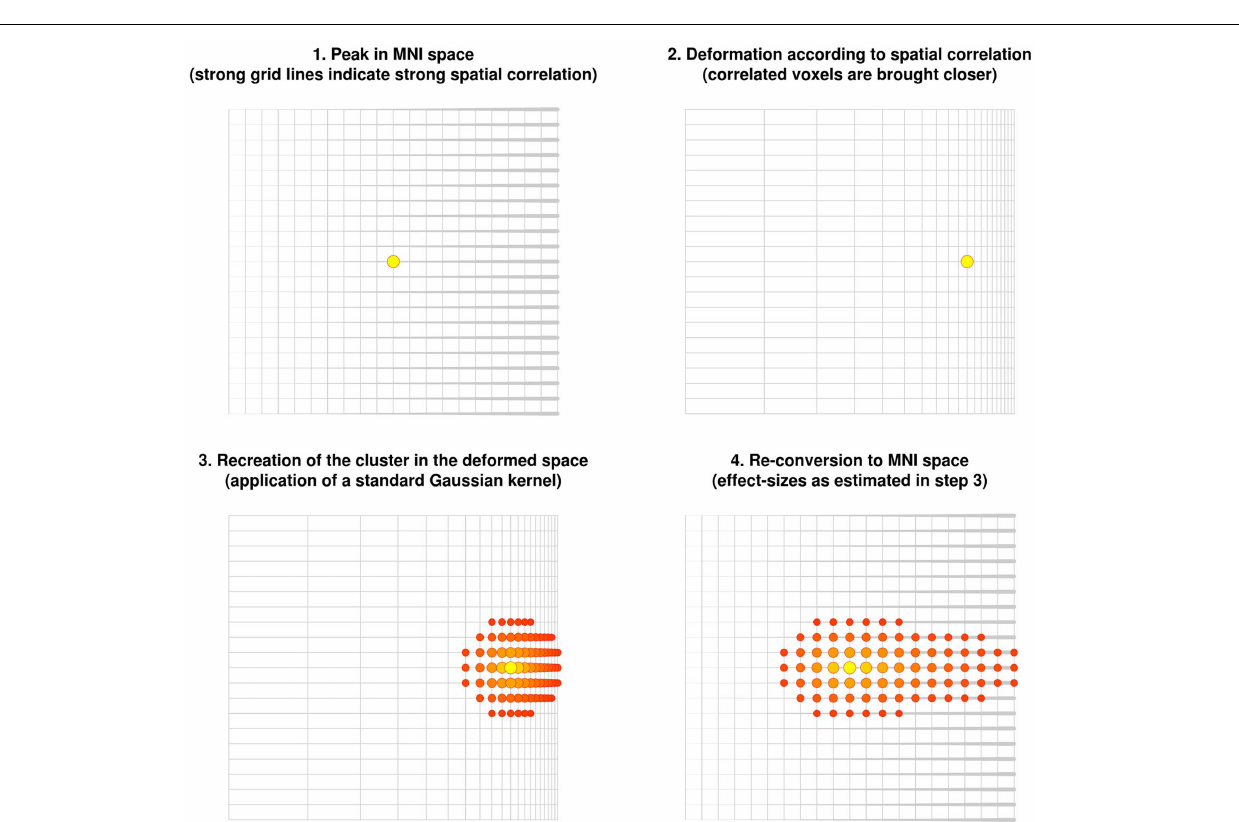
FIGURE 2 | Recreation of clusters using isotropic kernels in previous versions of effect-size signed differential mapping (ES-SDM) and activation likelihood estimation (ALE) . Note that the recreation of the